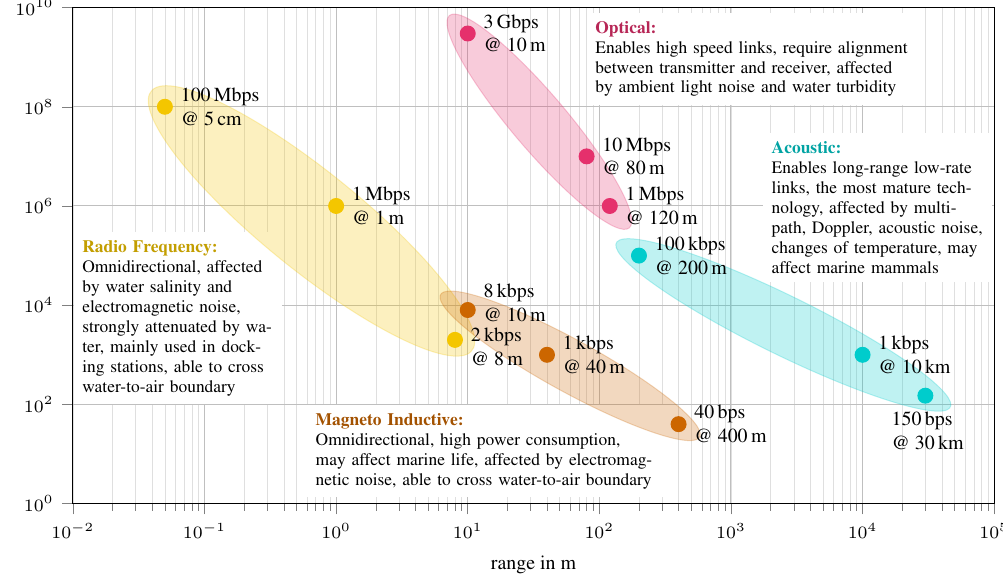
Figure 3. Comparison between underwater communication technologies (based on